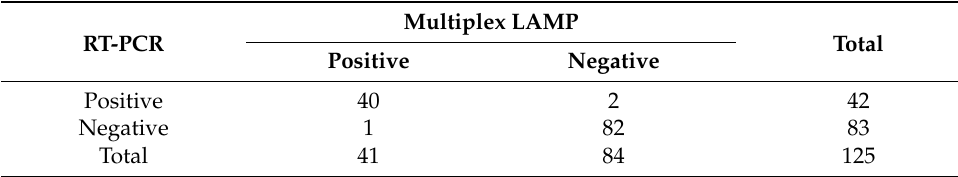
Table 3. A comparison of results between multiplex MS2-CoV-2-E LAMP and real-time RT-PCR